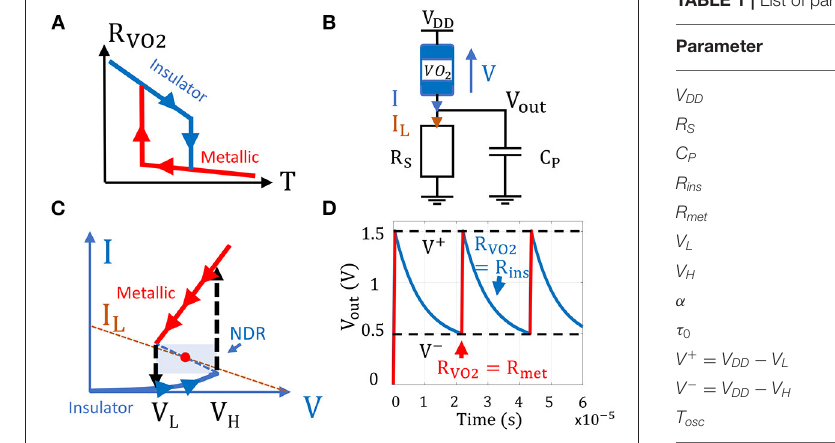
FIGURE 2 | (A) VO 2 resistance vs. temperature. R VO axis is in logarithmic 2 scale. (B) VO 2 oscillator circuit (C) VO 2 I-V curve showing the device hysteresis behavior. When its voltage reaches a threshold V H , it transitions from insulating to the metallic state. To transition from a metallic to insulating state, V must be lower than the threshold V L . (D) If the device is biased in its Negative Differential Resistance region (NDR), its state alternates between the metallic and insulating state, producing electrical oscillations.